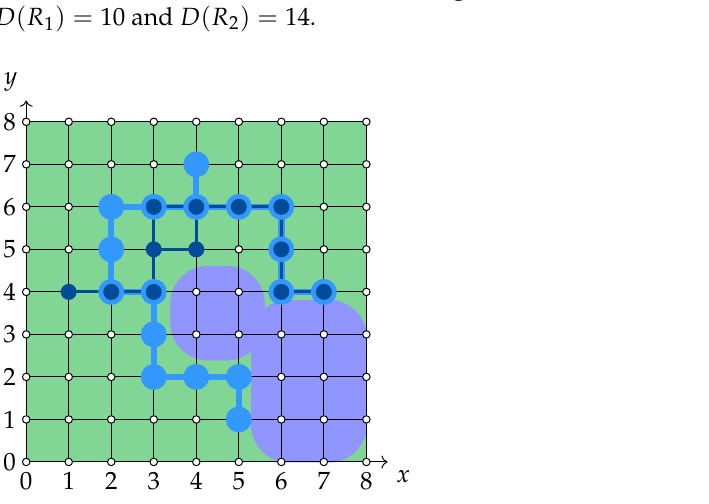
Figure 5. Initial position of the network. The nodes of Player 1 and Player 2 are indicated by dark blue, resp. light blue. Subgraph diameters D ( R 1 ) = 10 and D ( R 2 ) = 14.